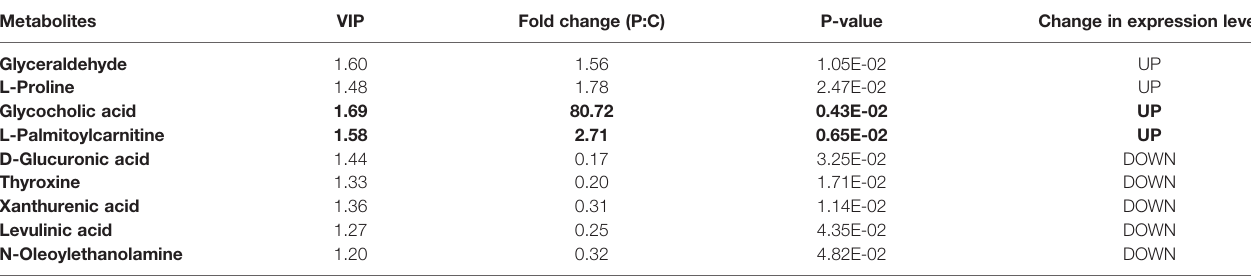
TABLE 2 | Differentially expressed placental metabolites among pregnant women with ICP and healthy pregnant women. Metabolites VIP Fold change (P:C) P-value